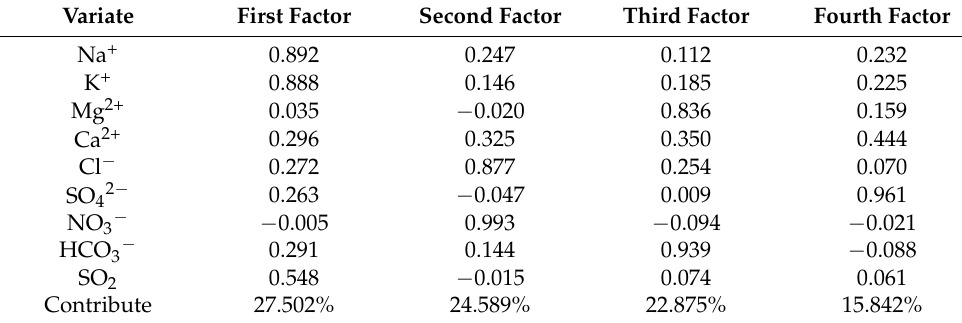
Table 2. Factor analysis results of the hydrochemical